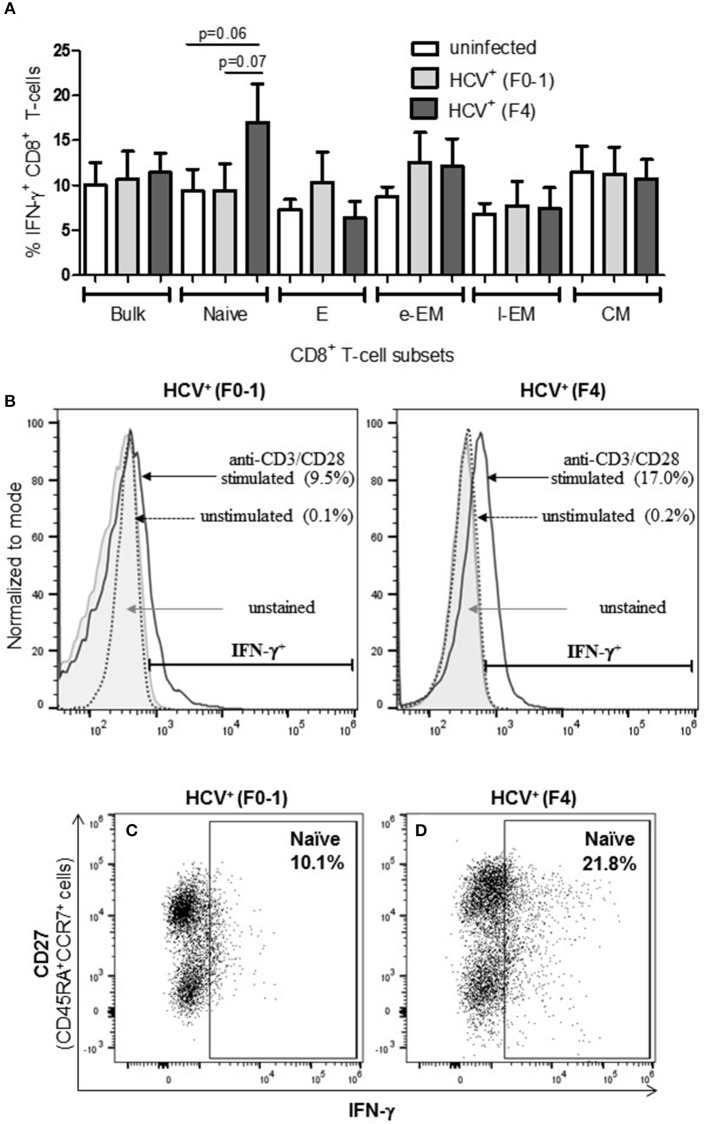
Advanced liver fibrosis/cirrhosis is associated with increased IFN-γ+ circulating naïve CD8+ T-cells in chronic HCV infection. After isolating CD8+ T-cells from PBMCs of uninfected controls (n = 9), HCV+ individuals with minimal or advanced liver fibrosis (F0-1, ≤7.0 kPa, n = 9; F4, ≥12.5 kPa, n = 5, respectively), cells were stimulated with anti-CD3/CD28 antibodies for 48 h, the proportion (%) of cells expressing intracellular IFN-γ was assessed by flow cytometry. (A) These data are summarized in bar graphs. (B) Histograms of IFN-γ flow cytometry traces of naïve cells to provide representative examples from each HCV+ group to show marker placement strategy relative to unstained cells and cells cultured with medium alone (Ctl) or stimulated with anti-CD3/CD28 antibodies and differences in %IFN-γ+ cells. The y-axis represents the relative number of cells after normalization to the mode (i.e., unit distribution) using FlowJo software. Representative dot plots of IFN-γ expression in naïve CD8+ T-cells in cells isolated from individuals with either (C) minimal or (D) advanced liver fibrosis are shown. Statistical trends in altered proportion of IFN-γ+ cells between groups are shown with a line and p-values approaching statistical significance (p ≤ 0.05) are shown, as determined by one-way ANOVA and Dunnett's post-test.